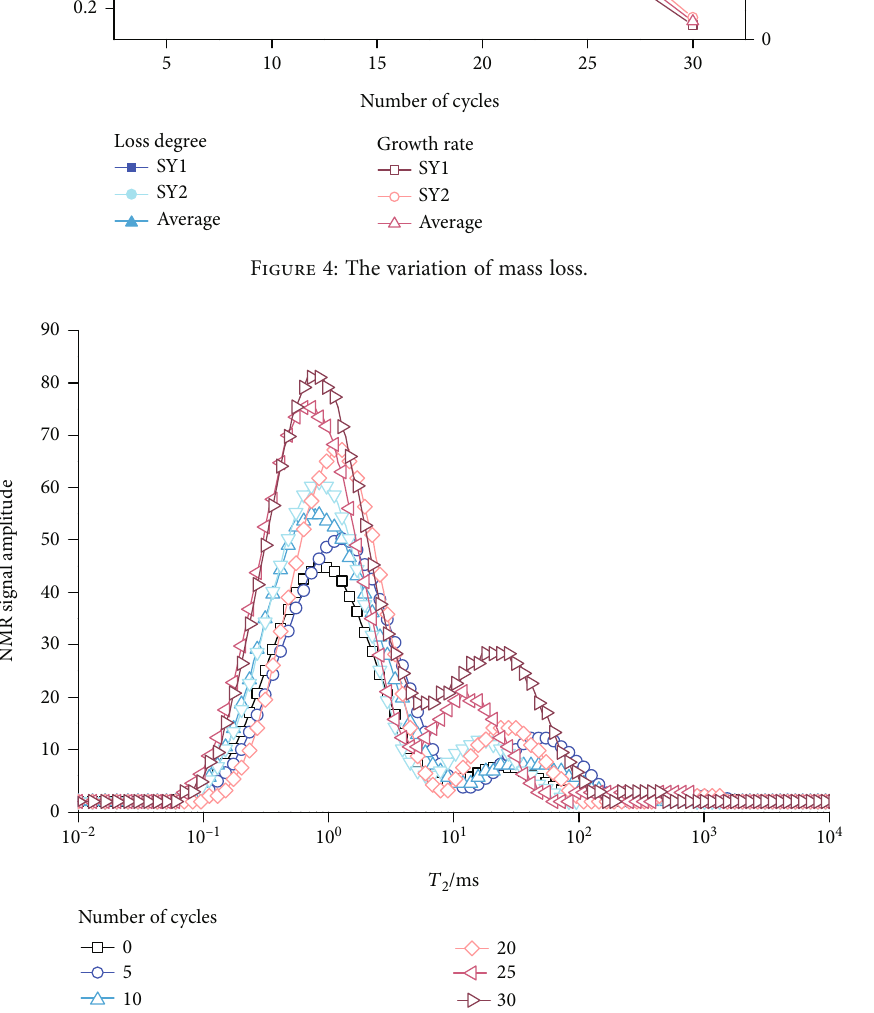
ff erent wetting-drying Figure 5: The T 2 curves of di